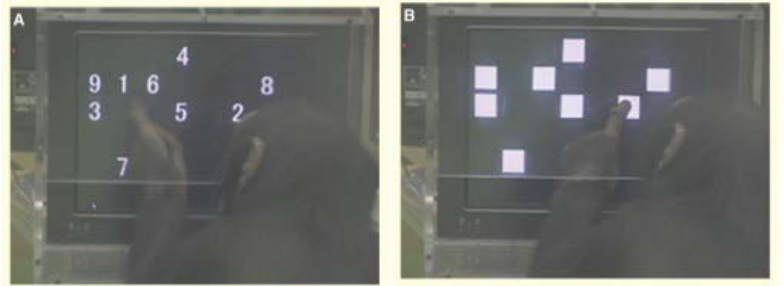
Figure 14. Chimpanzee Ayumu performing the limited-hold memory task. ( A ) Ayumu touches the first number. ( B ) The remaining numbers are covered by white squares.